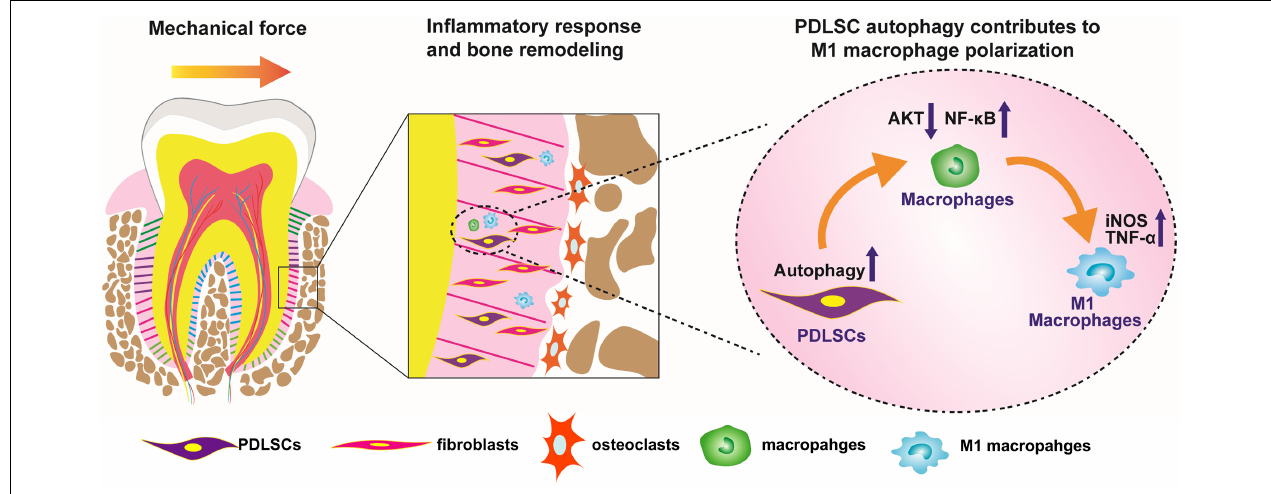
FIGURE 6 | Scheme of the study. Force-stimulated autophagy in PDLSCs steers macrophages into M1 phenotype, which contributes to the bone remodeling and tooth movement